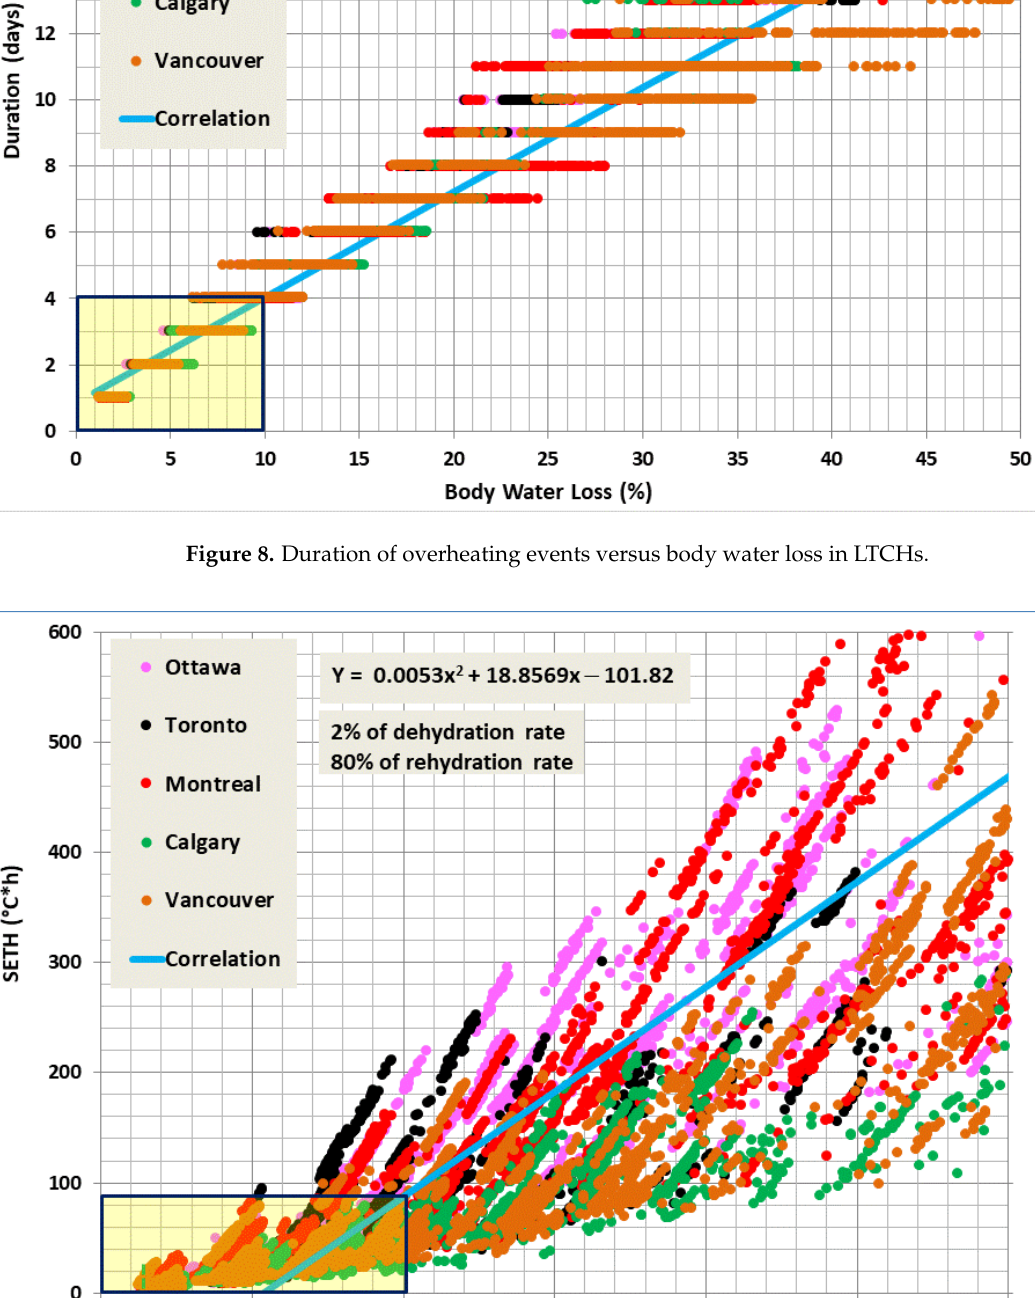
Figure 10. Intensity of overheating events versus maximum body core temperature in LTCHs. 3.2. Inter-Comparison of Overheating Criteria The proposed overheating method was compared with selected existing methods. Currently available methods are based on the fixed-space approach and use thermal com- fort indicators and ad hoc limit criteria. Methods applicable to LTCHs include CIBSE